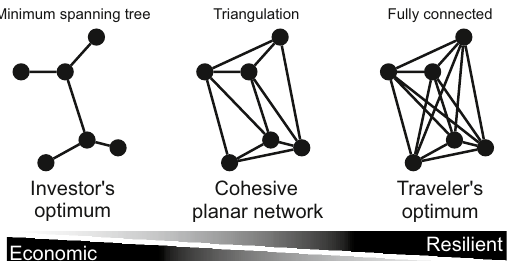
Figure 2. Optimal connected network solutions. Adapted from Ref. 40 . (Left) The investor’s optimal strategy for a connected network is to invest as little as possible, minimizing total link length 13 . Its solution is a minimum spanning tree, maximally economic but minimally resilient with low directness, inadequate for travelers. (Right) The traveler’s optimum connects all node pairs creating all direct routes. This solution is minimally economic, maximally resilient and direct, inadequate for investors. It also has crossing links and is therefore not a planar network. (Center) A both economic and resilient, as well as cohesive planar network solution in-between is the triangulation. In particular the minimum weight triangulation, approximated by the greedy triangulation, minimizes